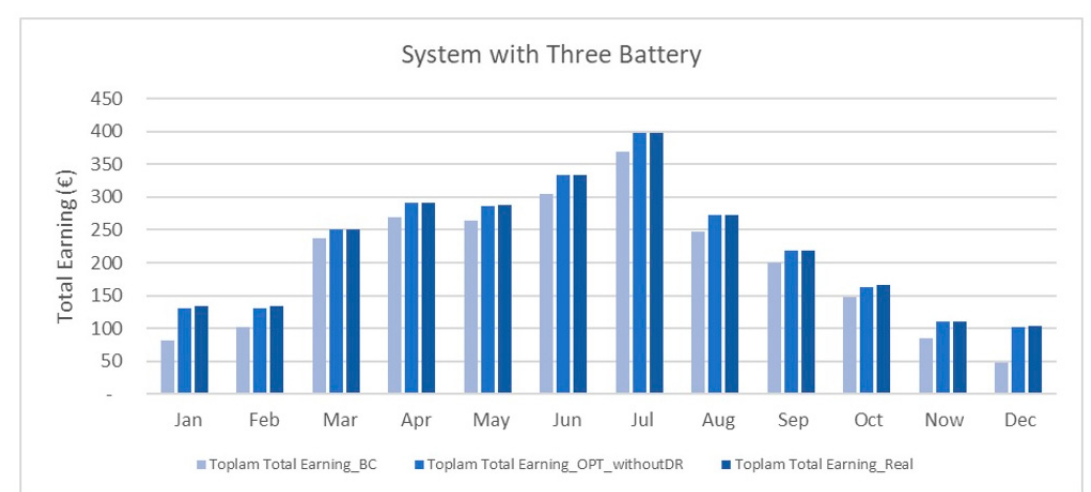
Figure 19. Methodology comparison for a three-battery case.